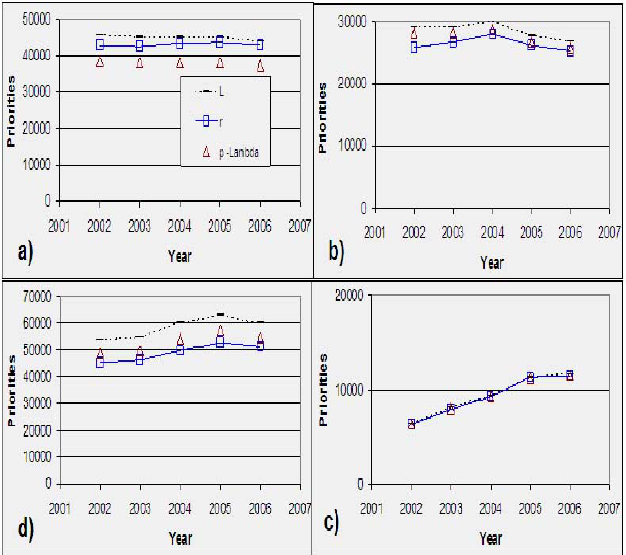
Fig. 9. The results for apparent randomness of r depend on blocs of origin of the patent families. Reading clockwise from top left: a) EPC, b) Japan, c) Others, d) US. L : dotted line; r : boxes; p − λ :